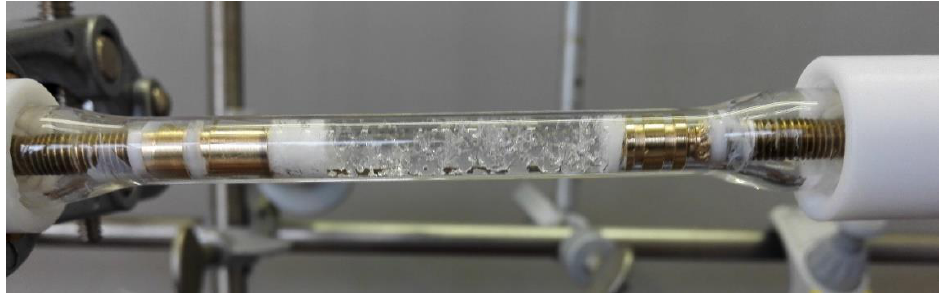
Figure 13. Developed glass reactor packed with superabsorber gel. 3.9. Studies on the Acetophenone Reduction in a Flow Process with a Superabsorber-Immobilized